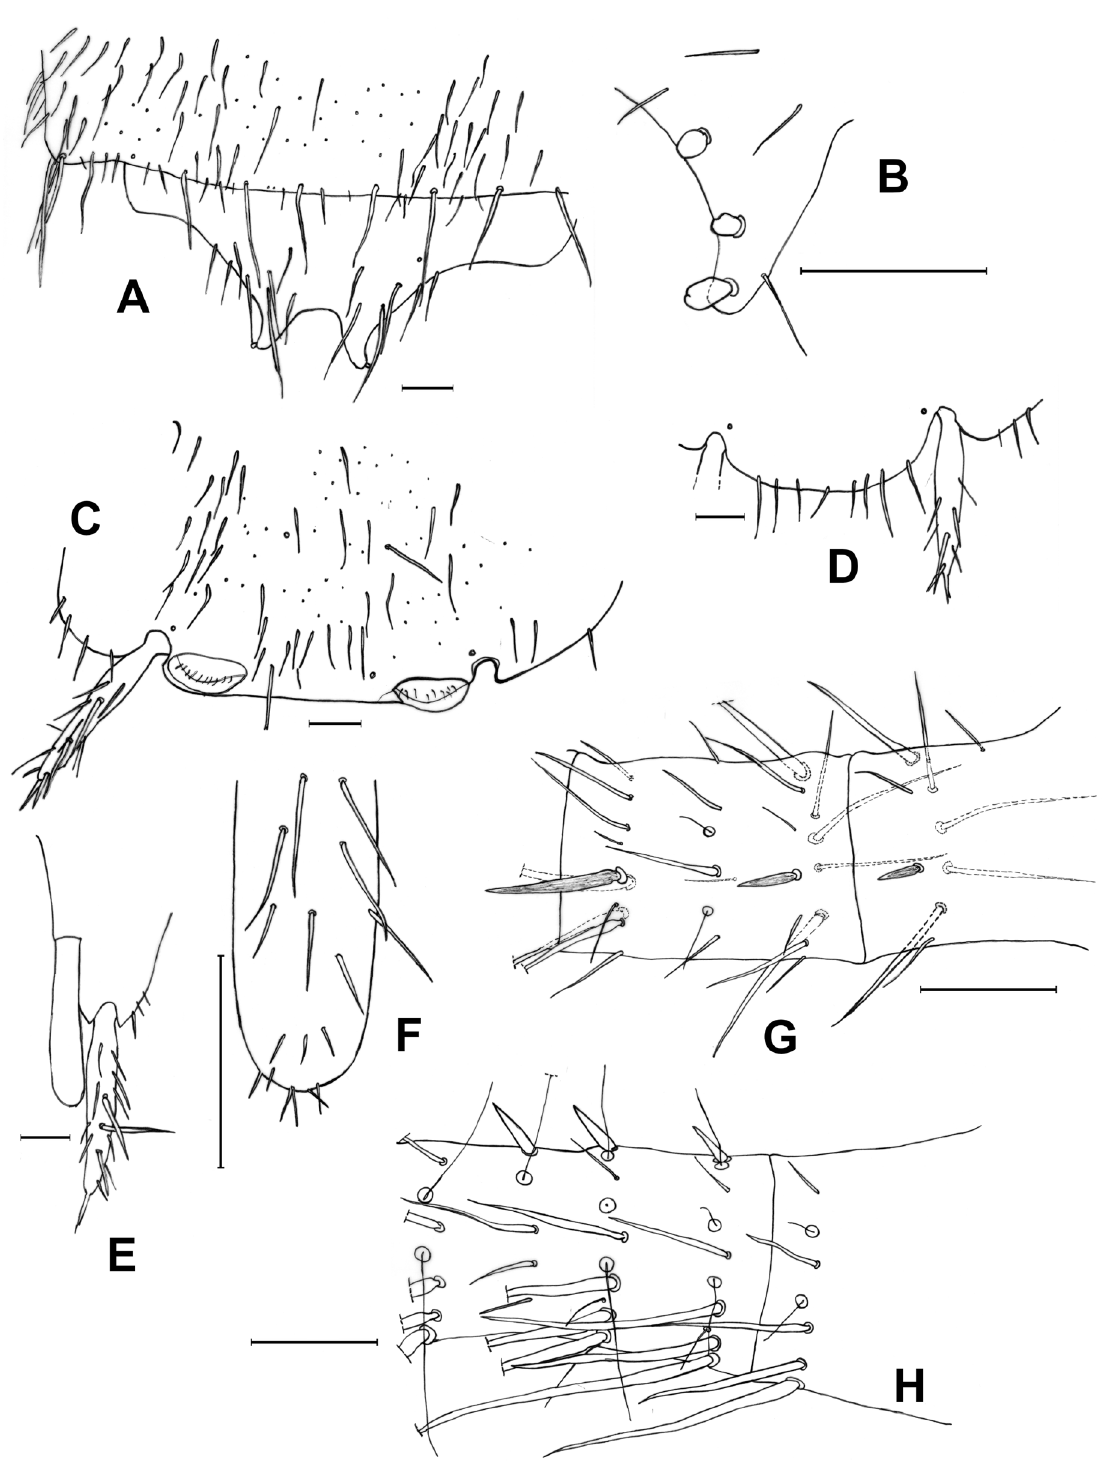
Fig. 11. Coletinia serrata Mendes, Molero-Baltanás, Bach de Roca & Gaju-Ricart sp. nov. Holotype, ♂ (MUHNAC, CZ-5646). A . Urotergite X. B . Detail of the posterolateral lobe of the urotergite X, with pegs. C . Urosternite V. D . Hind margin of the urosternite VIII. E . Coxite IX, stylus IX and paramere. F . Detail of the apical part of the paramere. G . First and second division of the cercus. H . First and basal divisions of the paracercus. Scale bars = 0.1